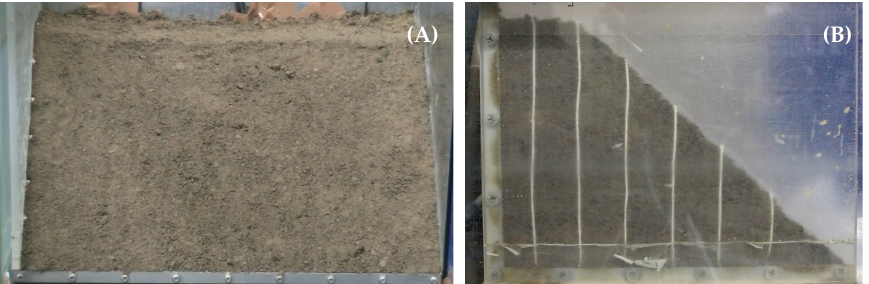
Figure 10. The initial shape of the model embankments, ( A ) front view ( B ) and side view.